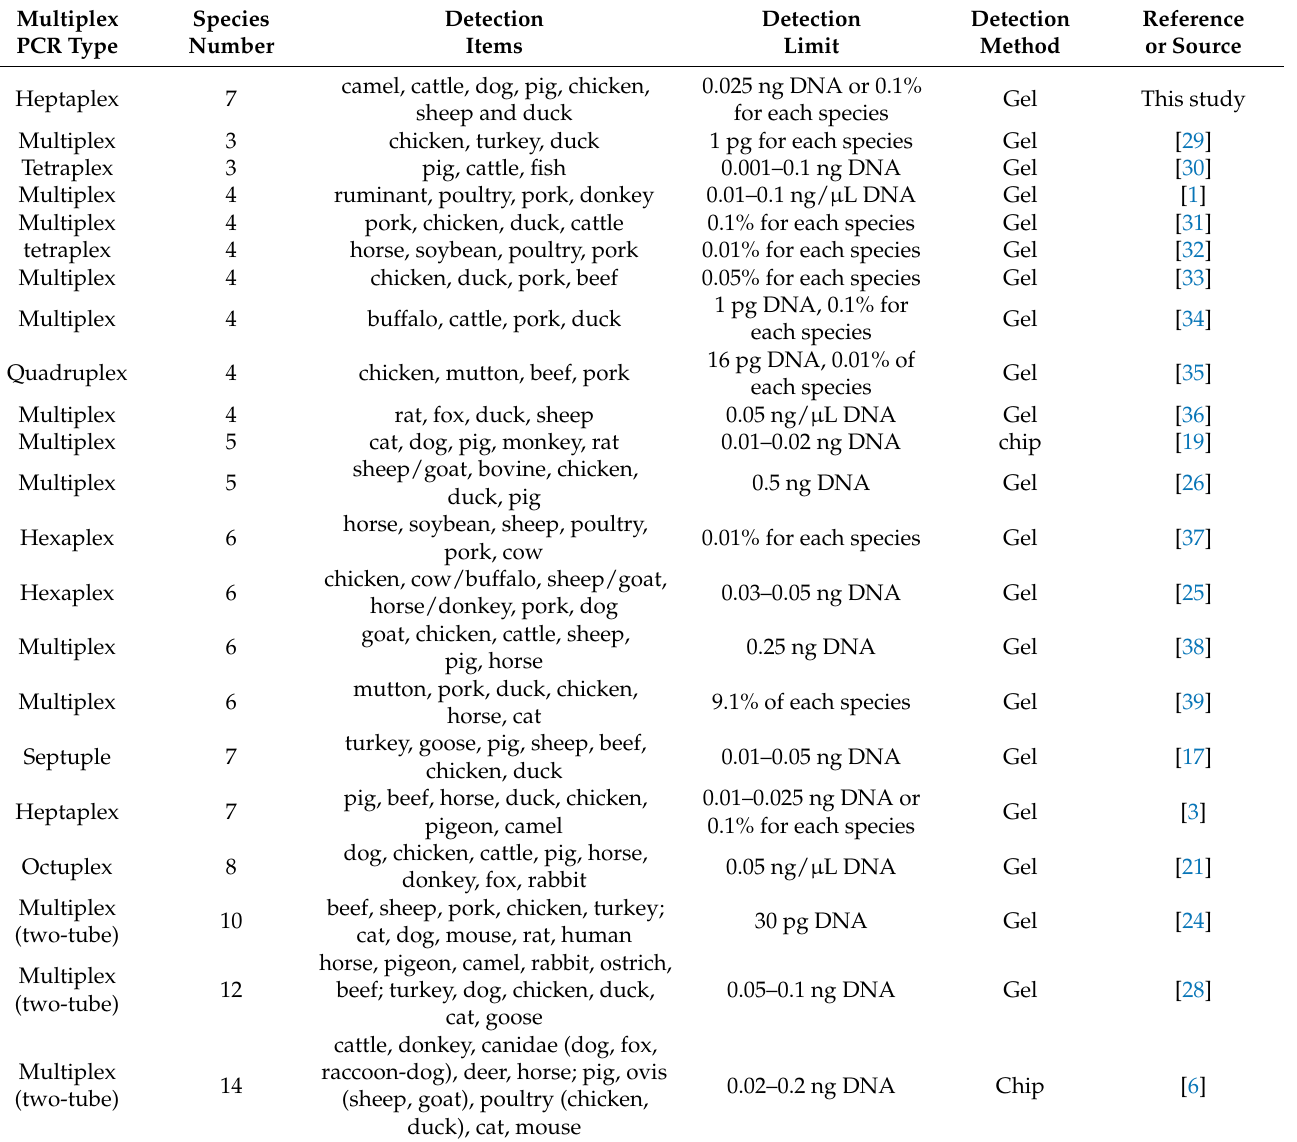
Table 3. Comparative analysis of multiplex assays for the identification of species origin of